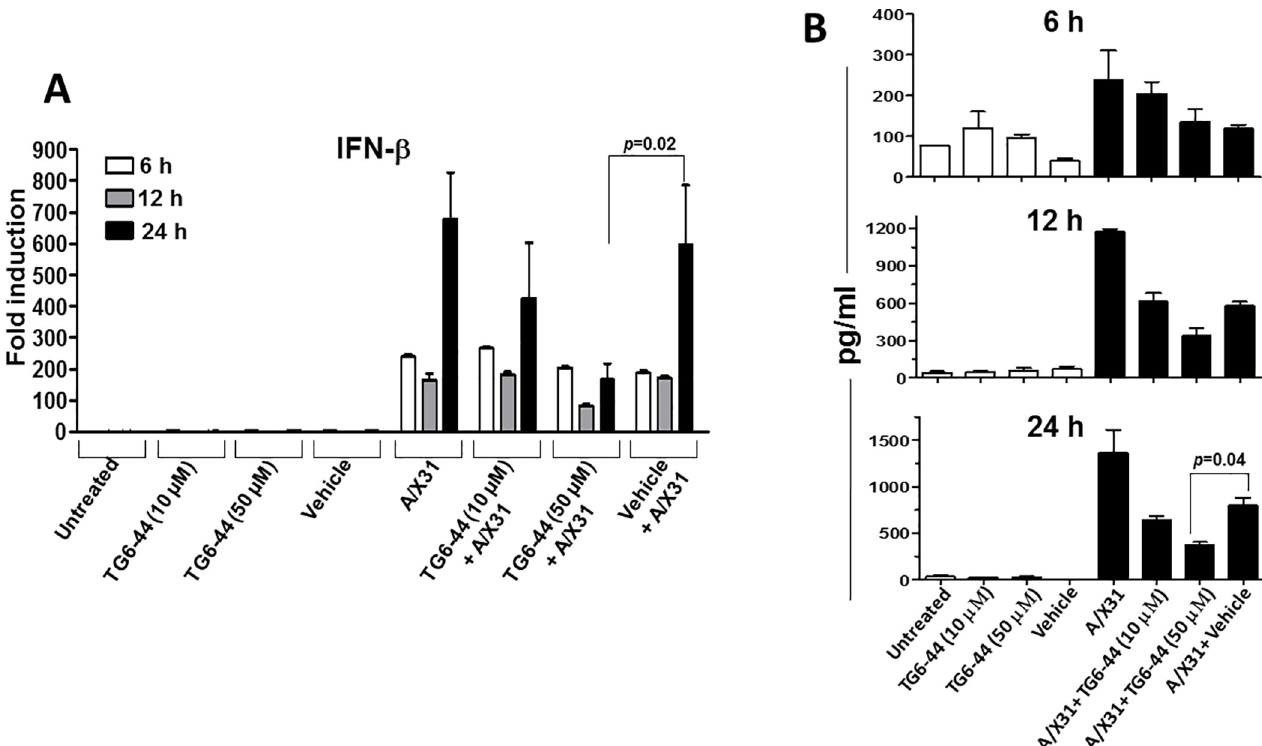
Fig 5. TG6-44 treatment decreases IFN- β levels in A/X31-infected THP-1 cells. Cell cultures from untreated, mock-treated, and/or TG6-44-treated A/X31-infected THP-1 cells were analyzed for IFN- β mRNA in cell lysates (A) and IFN- β protein in cell culture supernatants (B) at 6, 12, and 24 h p.i., as described in Materials and Methods. A represents results from three independent experiments. B represents results from one of three independent experiments. Values represent mean ± SEM.